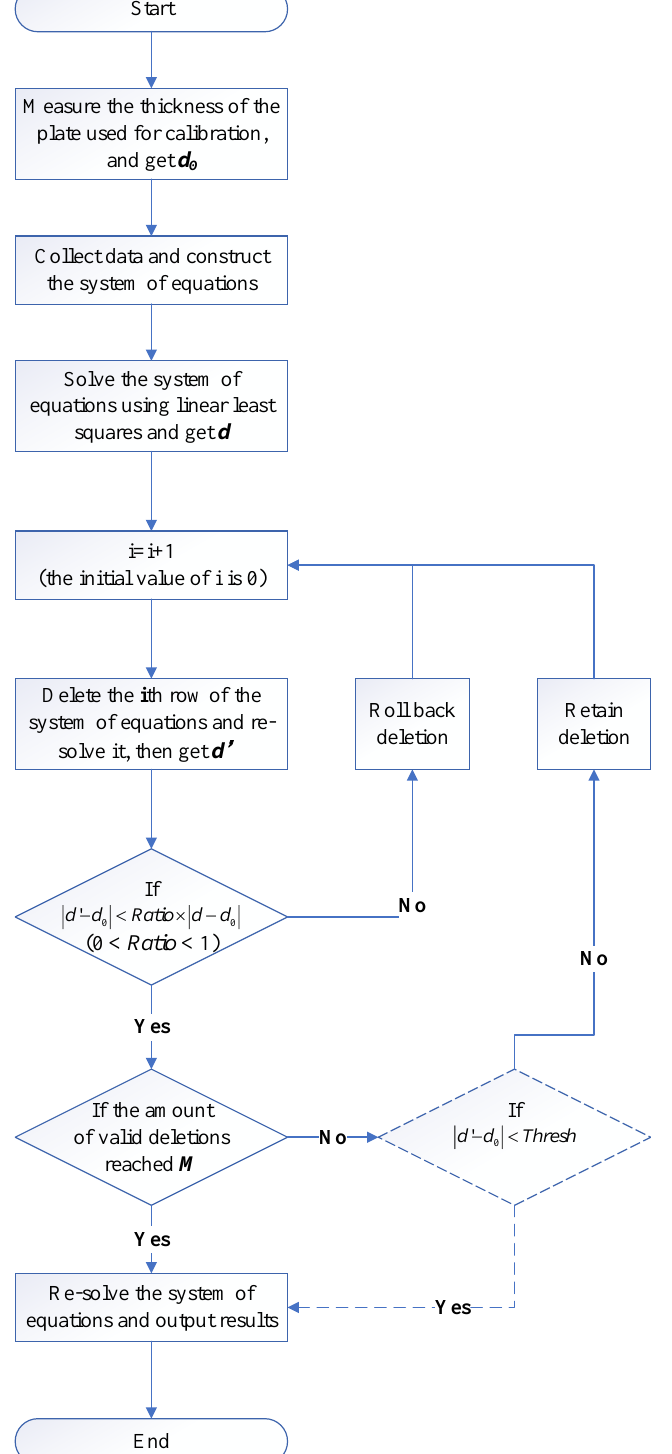
Figure 2. Whole procedure of the proposed calibration